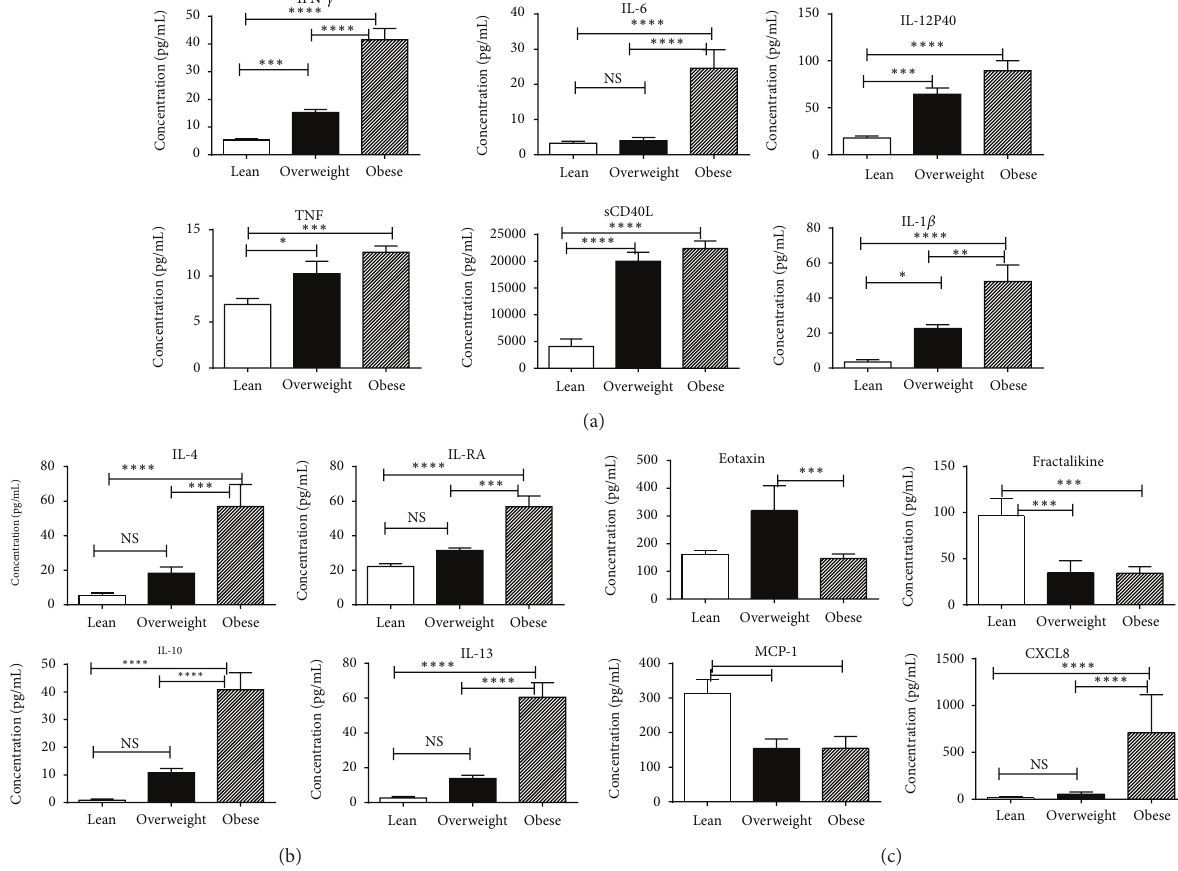
Figure 1: Measurement of cytokines by multiplex cytokine bead array (CBA) in plasma of lean ( N #28), overweight ( N #10), and obese ( N #10) chimpanzees using Bio-Rad 200, Luminex technology. The results are expressed as pg/mL concentration and are an average of two distinct experiments. (a) Shows proinflammatory cytokines, (b) anti-inflammatory cytokines, and (c) chemokine. See method section for experiment details. Comparison between groups of chimpanzees was done by one-way analysis of variance with the Kruskal-Wallis test and Gaussian approximation with Dunn’s multiple comparison tests. Data are presented as group means ± SD. Only differences with a probability less than 0.05 were considered to be significant. All statistical analyses were conducted using GraphPad Prism 6.00 (GraphPad Software, San Diego, California,